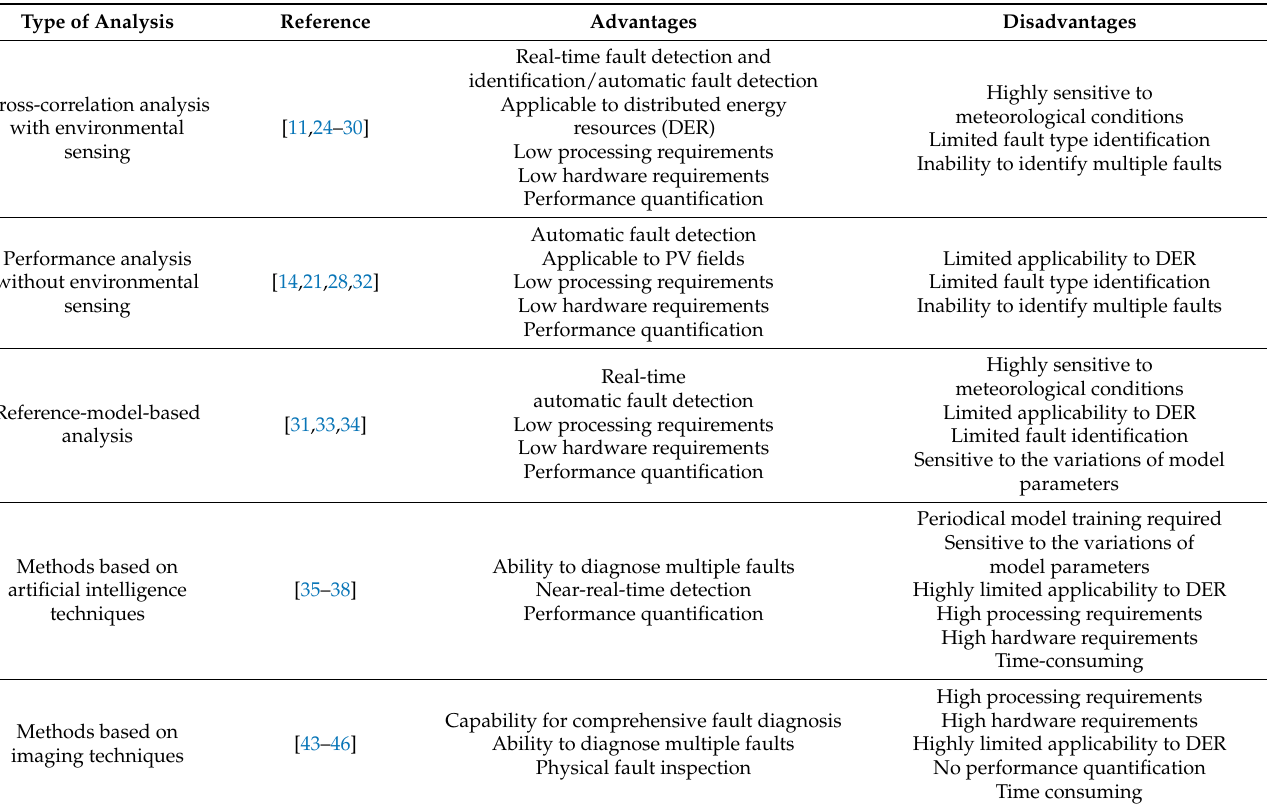
Table 1. Summary of the different types of methods used for PV system fault detection in the